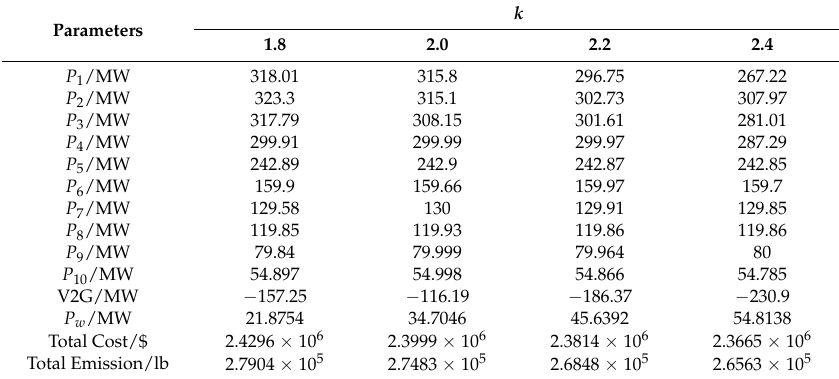
Table 7. Compromise dispatching schemes obtained for different shape factors.